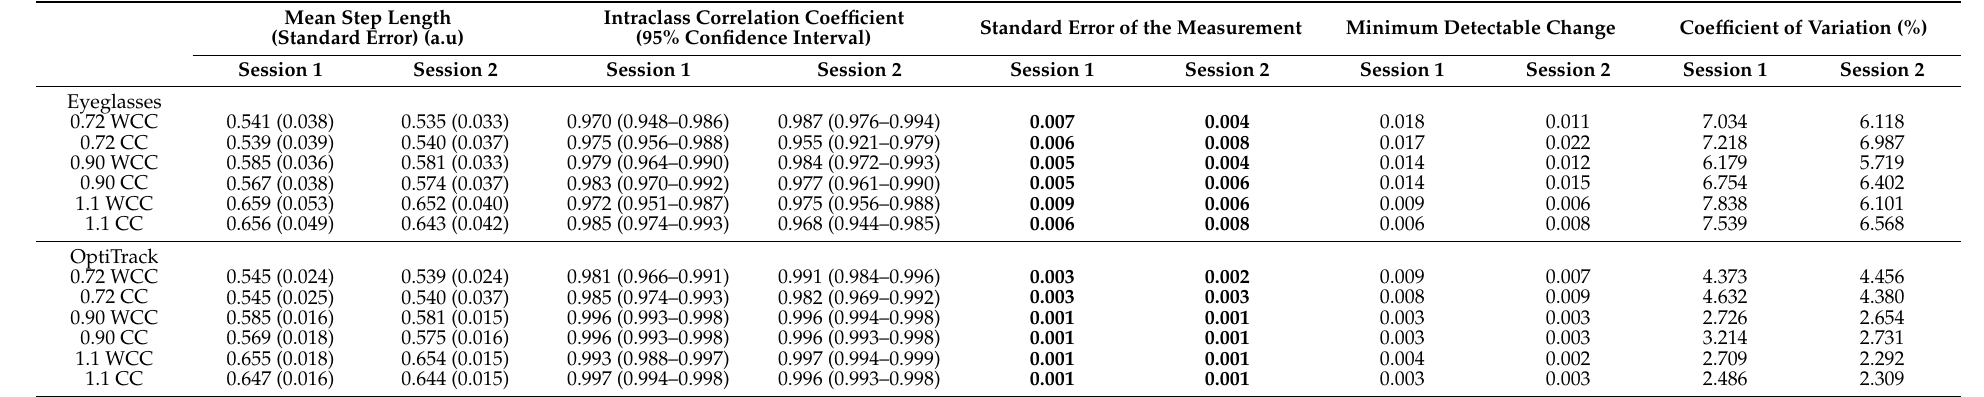
Table 2. Mean step length normalized by the lower limb length, intraclass correlation coefficient (95% confidence interval), standard error of the measurement, minimum detectable change and coefficient of variation (%) measured with the optoelectronic system (OptiTrack) and the eyeglasses during 30 s of gait for both